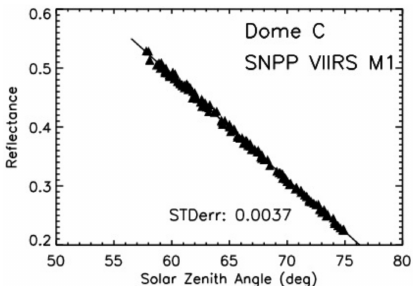
Figure 1. Relationship between L1B reflectance and solar zenith angle for SNPP VIIRS M1 (0.412 µ m) over the Dome C site. Each point represents one overpass and data are collected from the initial three years of the mission. A linear regression line is shown in the